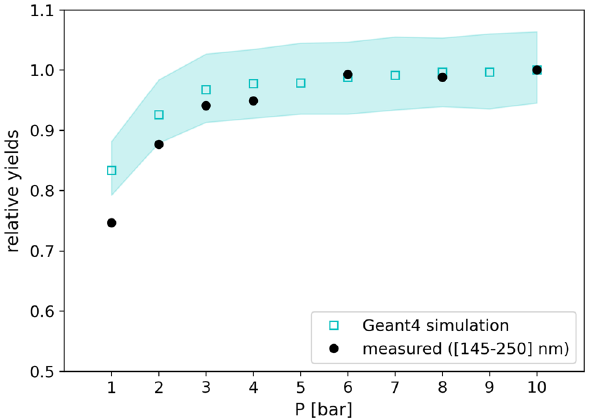
Fig. 10 Measured yields in the 145–250 nm band relative to the aver- age of the two highest points and comparison with Geant4 simulations. The band includes the spread on the assumed reflectivity values